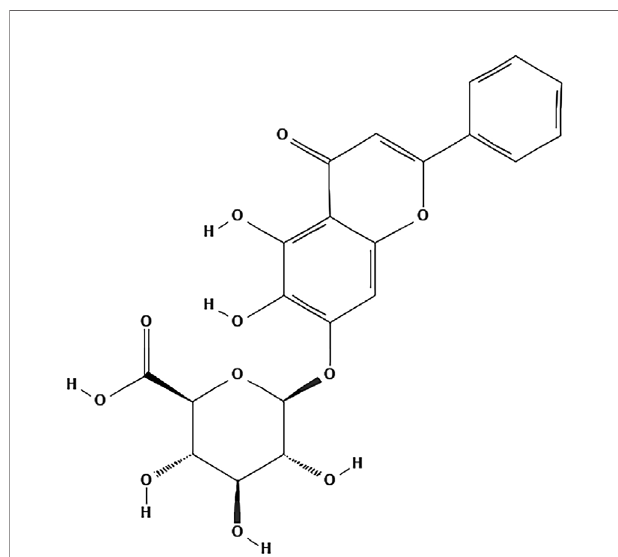
FIGURE 2 | The chemical structure of